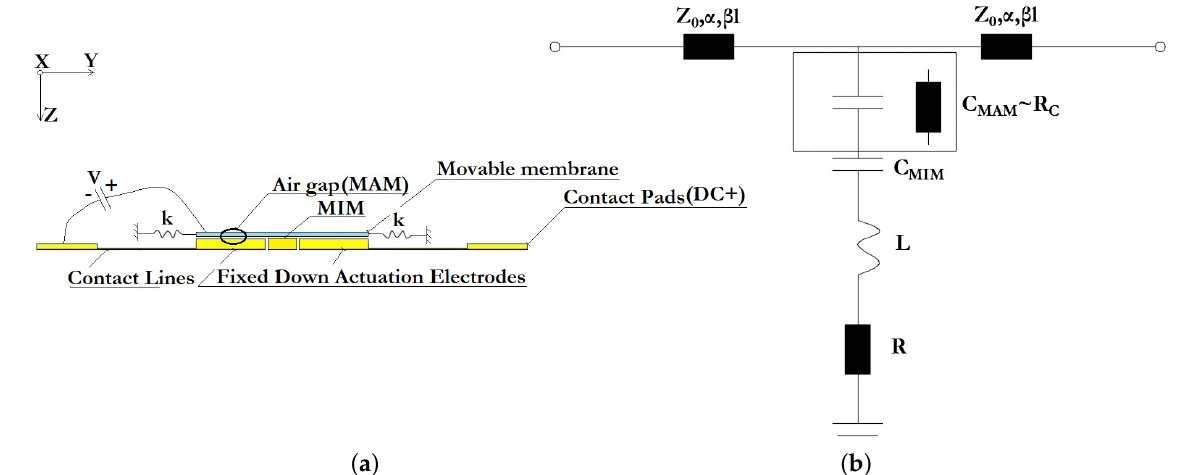
Figure 4. Schematic view of the developed capacitive RF MEMS switches: ( a ) the one-dimensional model of the displacement of the movable membrane during electrostatic activation; ( b ) the equivalent electrical